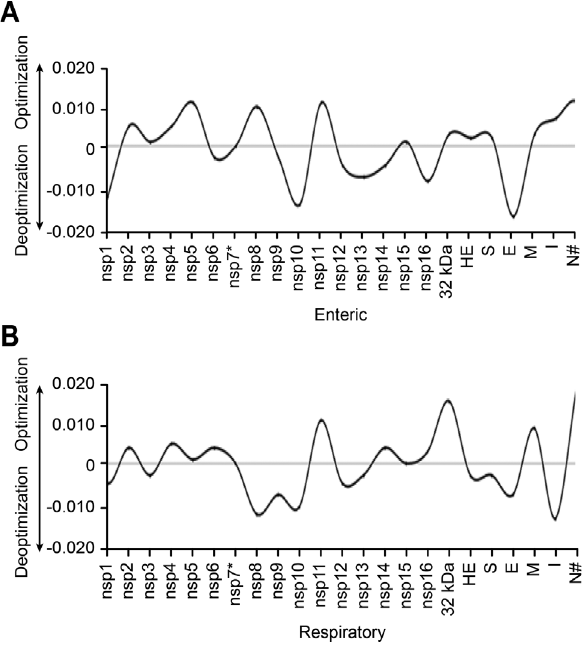
Figure 1 - (cid:2) CAI for BCoV and HCoV-OC43 coding regions/mRNAs for nsps1-16, ns2 and structural proteins HE, S, E, M, I and N regarding (A) human cholecystokinin (CCK) and (B) human surfactant protein A1 (SFTPA1) mRNAs as highly expressed, tissue specific proteins from the enteric and respiratory tracts, respectively. Positive (cid:2) CAI values indicate viral codon usage optimization, while negative values indicate deoptimization. *=lowest distance from HCoVs lower CAI limit for both HCoV-OC43 and BCoV; #=highest distance from HCoVs lower CAI limit for both HCoV-OC43 and BCoV.